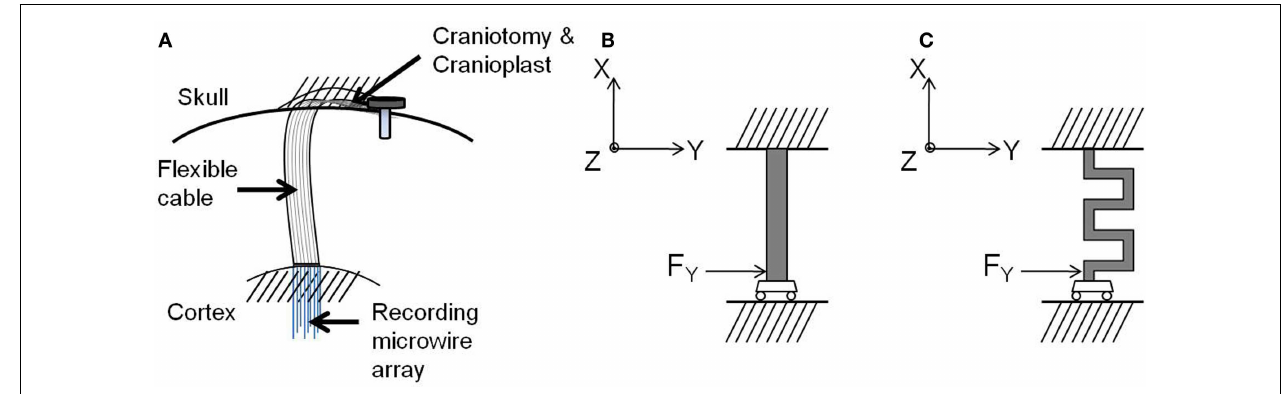
FIGURE 5 | (A) Schematic drawing of the electrode implanted into the brain, (B) free-body diagram of the straight cable, and (C) free-body diagram of the serpentine cable. Images not drawn to scale.